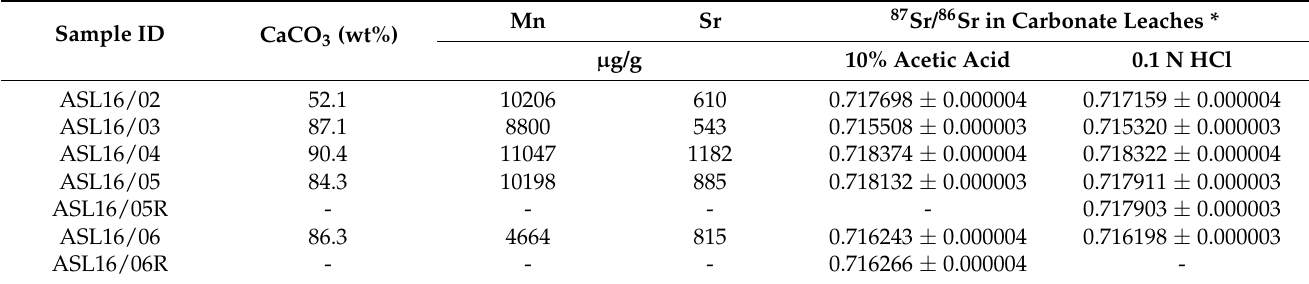
Figure 4. The Re–Os isochron plot of the siltstones from the Guryul Ravine showing the deviation from the “250-Ma” reference line. Table 2. Elemental and Sr isotopic data for carbonate samples from the Mikin Formation, Spiti